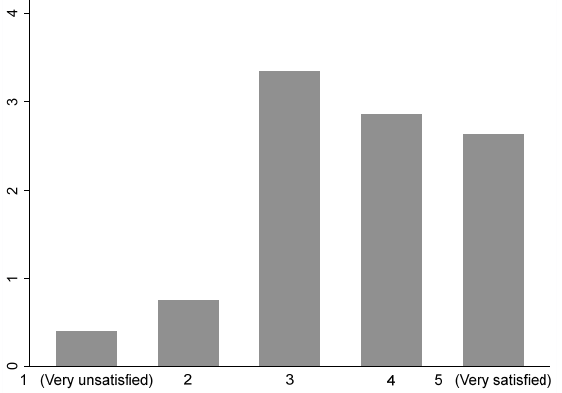
Figure 1. Distribution of subjective happiness. Table 1. Urban resilience